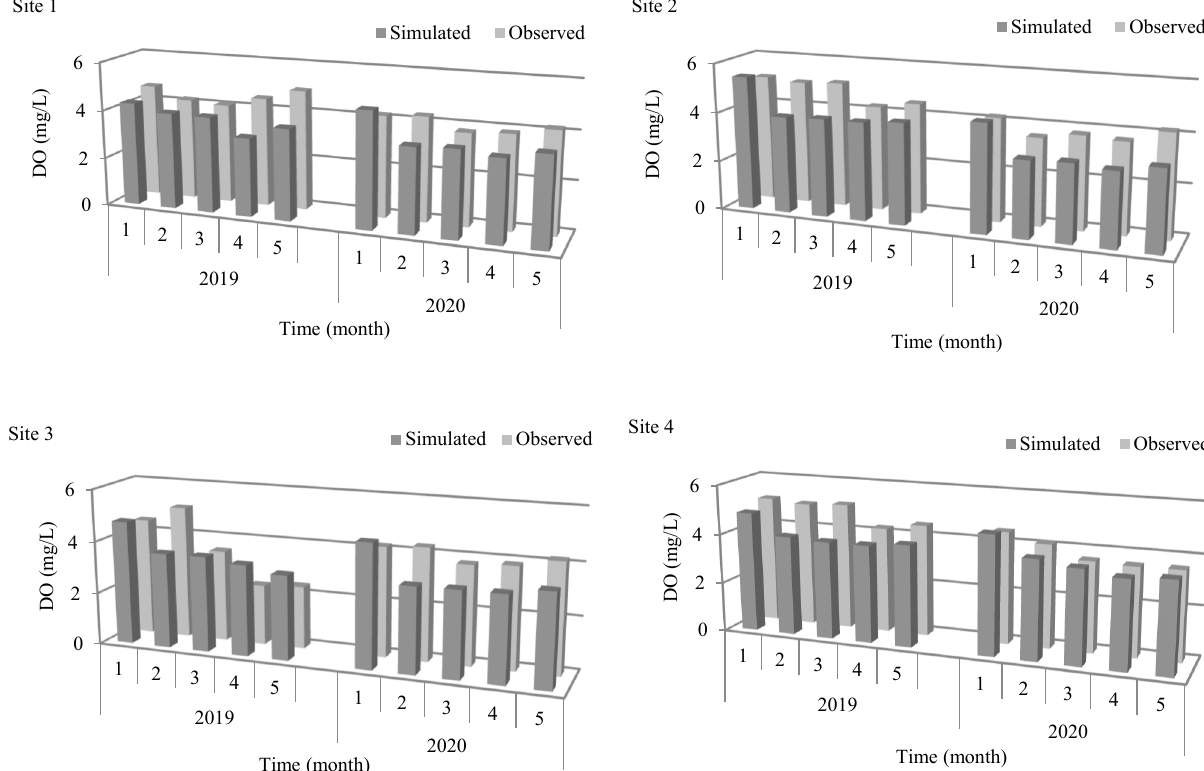
Figure A2. Calibrated and verified results of DO concentration at the four locations within the study area for the years 2019 and 2020.